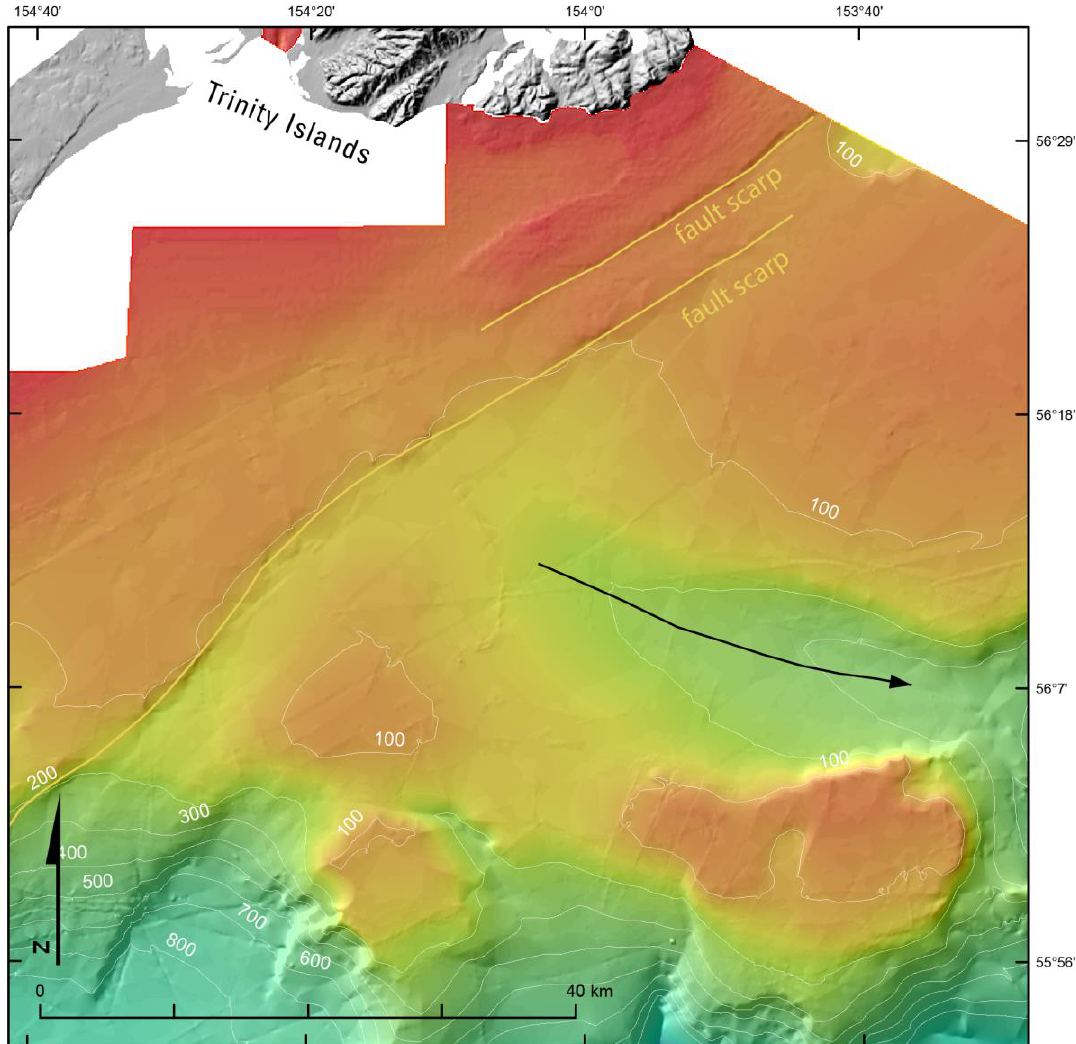
Figure 6. Yellow lines show two fault scarps in the study area to the south of the Trinity Islands, southwest of Kodiak Island. Location of the figure is shown on Figure 5 and the symbology is the same as Figure 5. The northwestern scarp is 20 – 25 m tall and the southeastern scarp is 40 – 45 m tall. See text for further discussion.